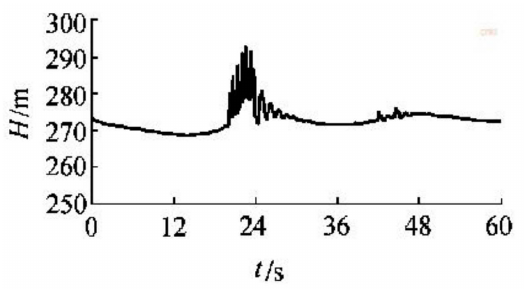
Figure 17. Change process of the head in a section of the SCTT [24].